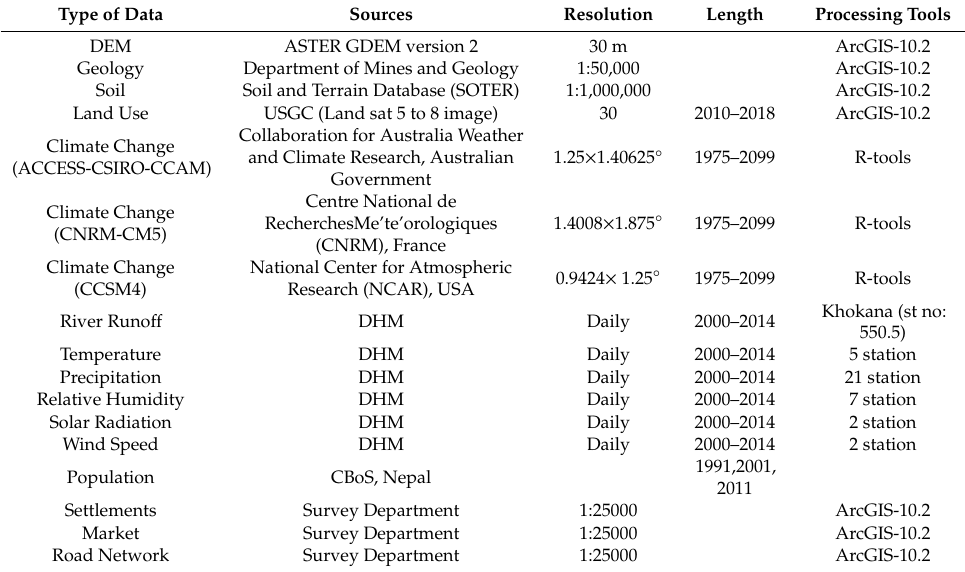
Table 1. Sources and scales of database used in this